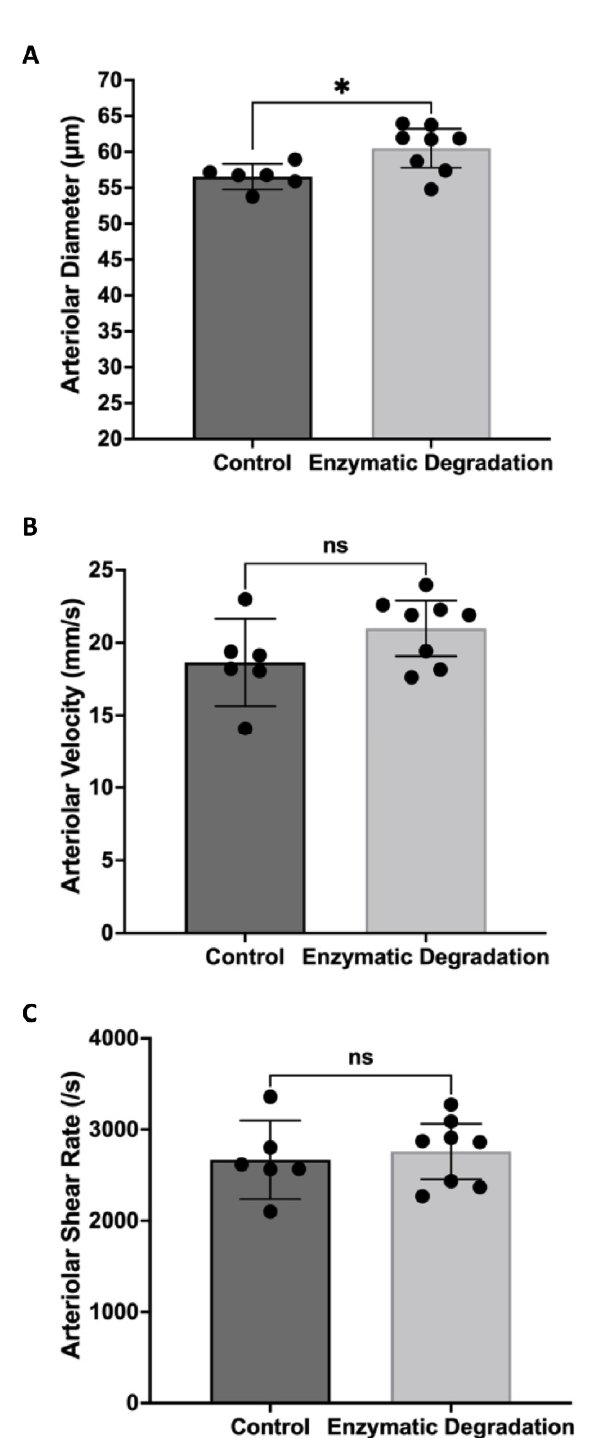
Figure 2. Retinal Arteriolar Hemodynamics. Retinal arteriolar diameter ( A ), velocity ( B ), and shear rate ( C ) in control mice (n = 6) and mice infused with glycocalyx-degrading enzymes (n = 8); means with 95% confidence intervals. * p < 0.05 and ns = nonsignificant.